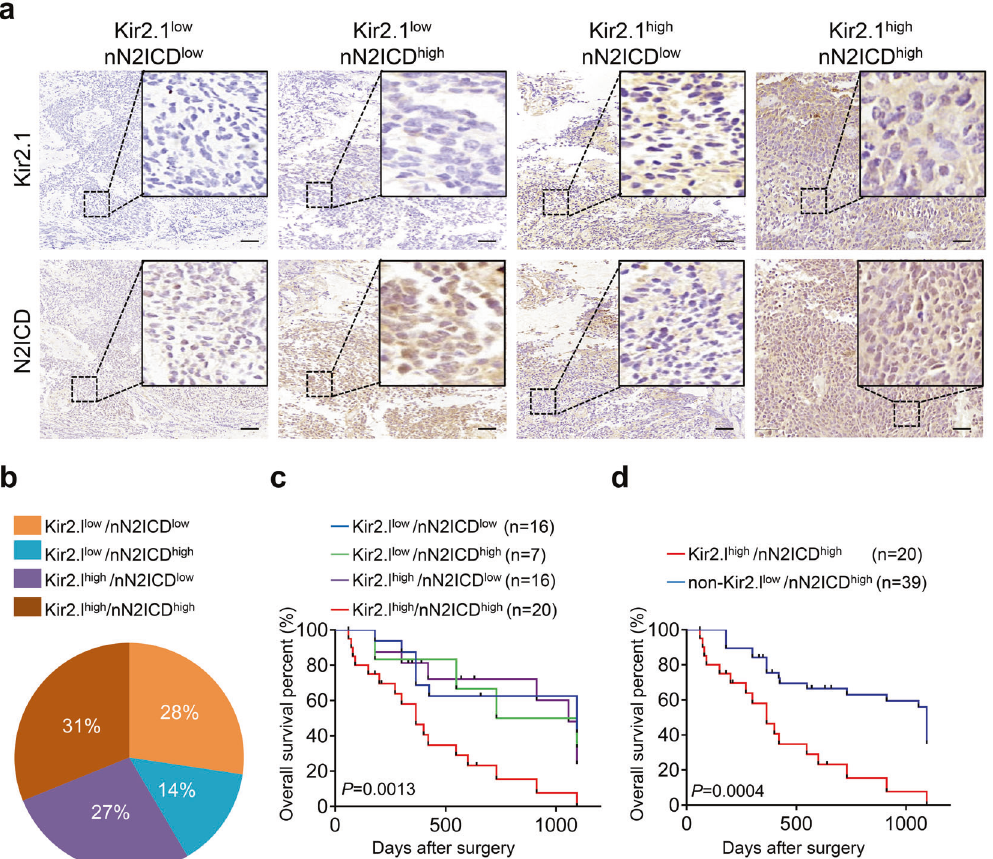
Fig. 6 Kir2.1 high -nN2ICD high de fi nes a novel subtype of non-WNT/SHH MBs with the poorest outcome. a Representative IHC images showing the expression status of Kir2.1 and nN2ICD, including Kir2.1 low /nN2ICD low , Kir2.1 low /nN2ICD high , Kir2.1 high /nN2ICD low , and Kir2.1 high /nN2ICD high in non-WNT/SHH MBs. Scale bar = 100 μ m. b The percentage of patients with different Kir2.1/nN2ICD expression status in non-WNT/SHH MBs. c Kaplan – Meier survival curves showing the poorest outcome of Kir2.1 high /N2ICD high patients among the patients with different Kir2.1/N2ICD expressing non-WNT/SHH MBs. P = 0.0013, Log-rank test. d Kaplan – Meier survival curves showing a poorer outcome of the Kir2.1 high / N2ICD high subtype patients than patients with non-Kir2.1 high /N2ICD high subtypes in non-WNT/SHH MBs. P = 0.0004, Log-rank